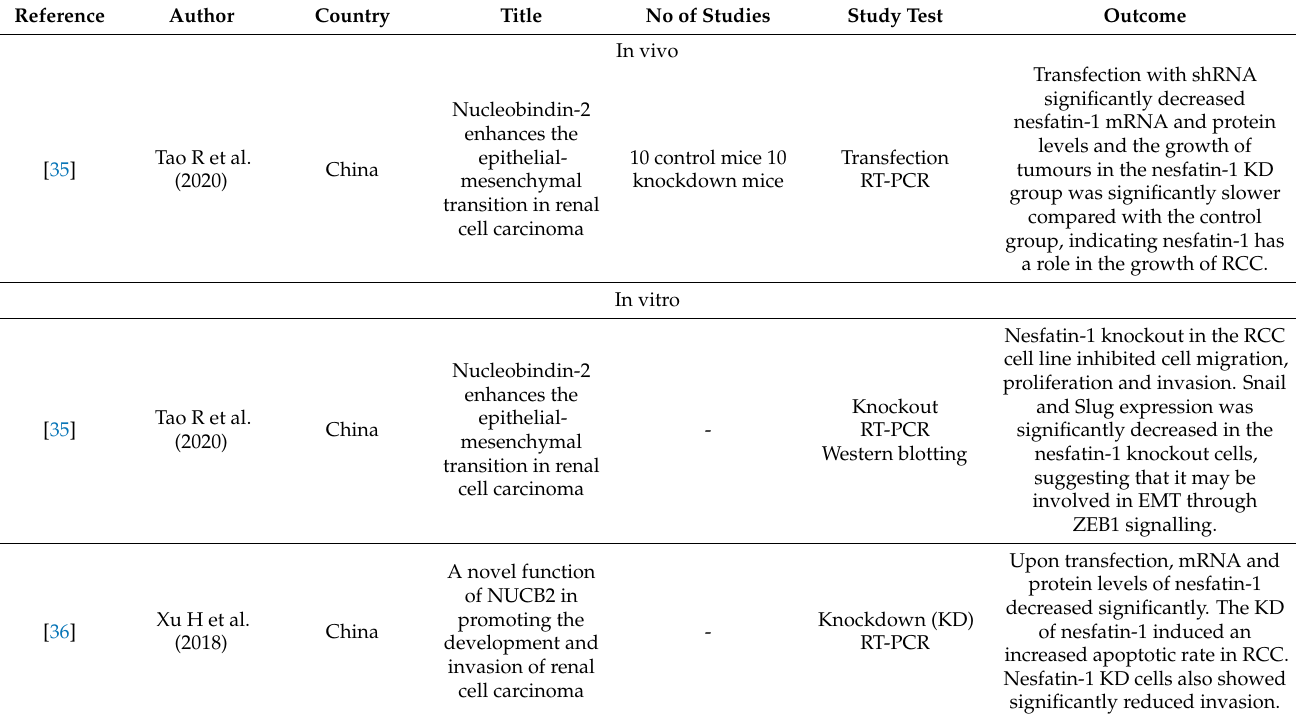
Table 3. Summary of Nesfatin-1 using in vivo and in vitro pre-clinical